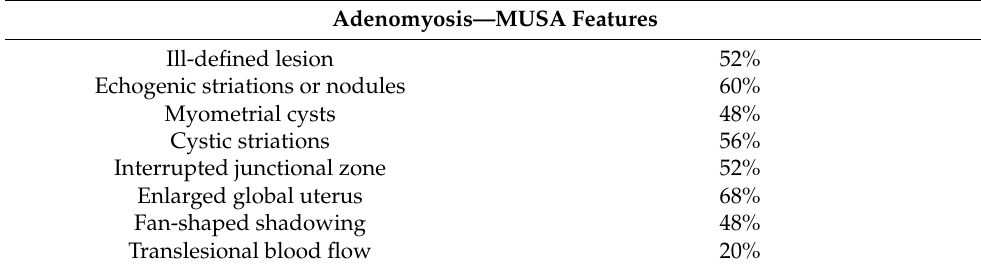
Table 2. Prevalence of MUSA features among histologically confirmed adenomyosis, as identified upon